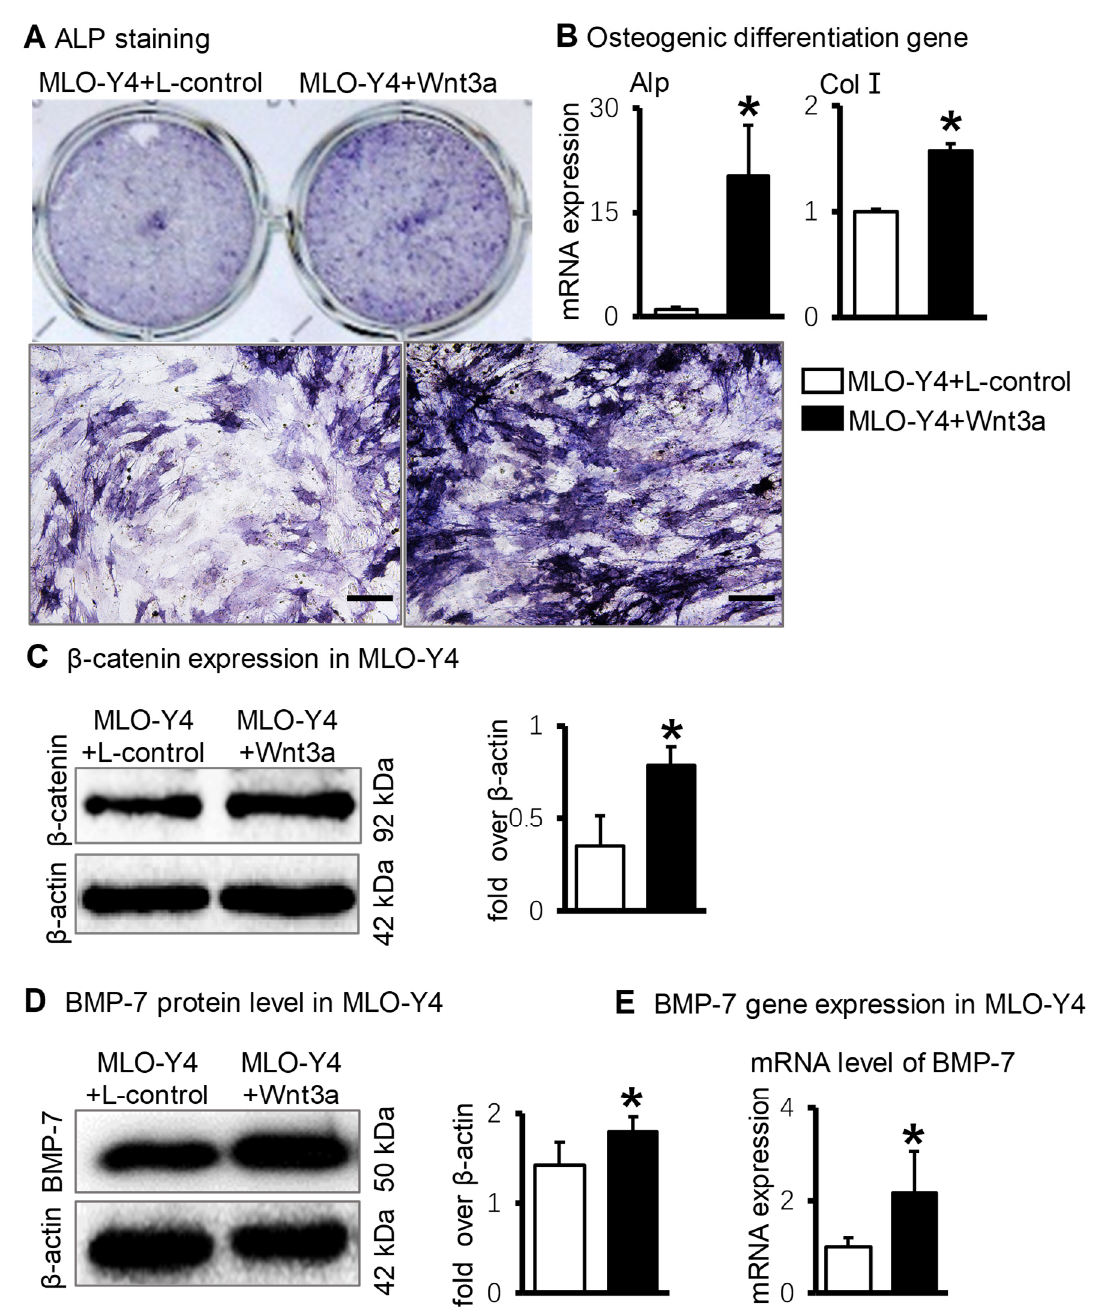
Figure 2. BMP-7 expression in Wnt-activated osteocytes in vitro. ( A ). ALP staining in the coculture system of Wnt3a-treated MLO-Y4 cells and ST2 cells. ( B ). Osteogenic marker gene expression in the coculture system of Wnt3a-treated MLO-Y4 cells and ST2 cells. ( C ). The protein level of β -catenin in MLO-Y4 cells after treatment with Wnt3a by Western blotting. ( D ). The protein level of BMP-7 in MLO-Y4 cells after treatment with Wnt3a based on Western blotting. ( E ). The gene expression of BMP-7 in MLO-Y4 cells after treatment with Wnt3a using RT-qPCR. * p < 0.05, compared with MLO-Y4+L-control group. Scale bar: ( A ) 50 µ